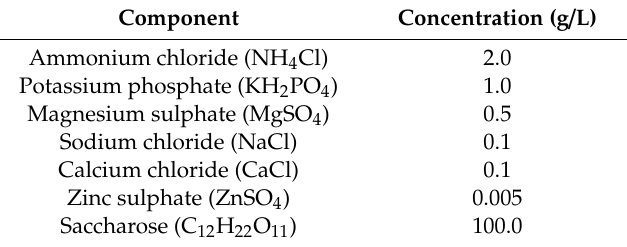
Table 2. Mineral medium